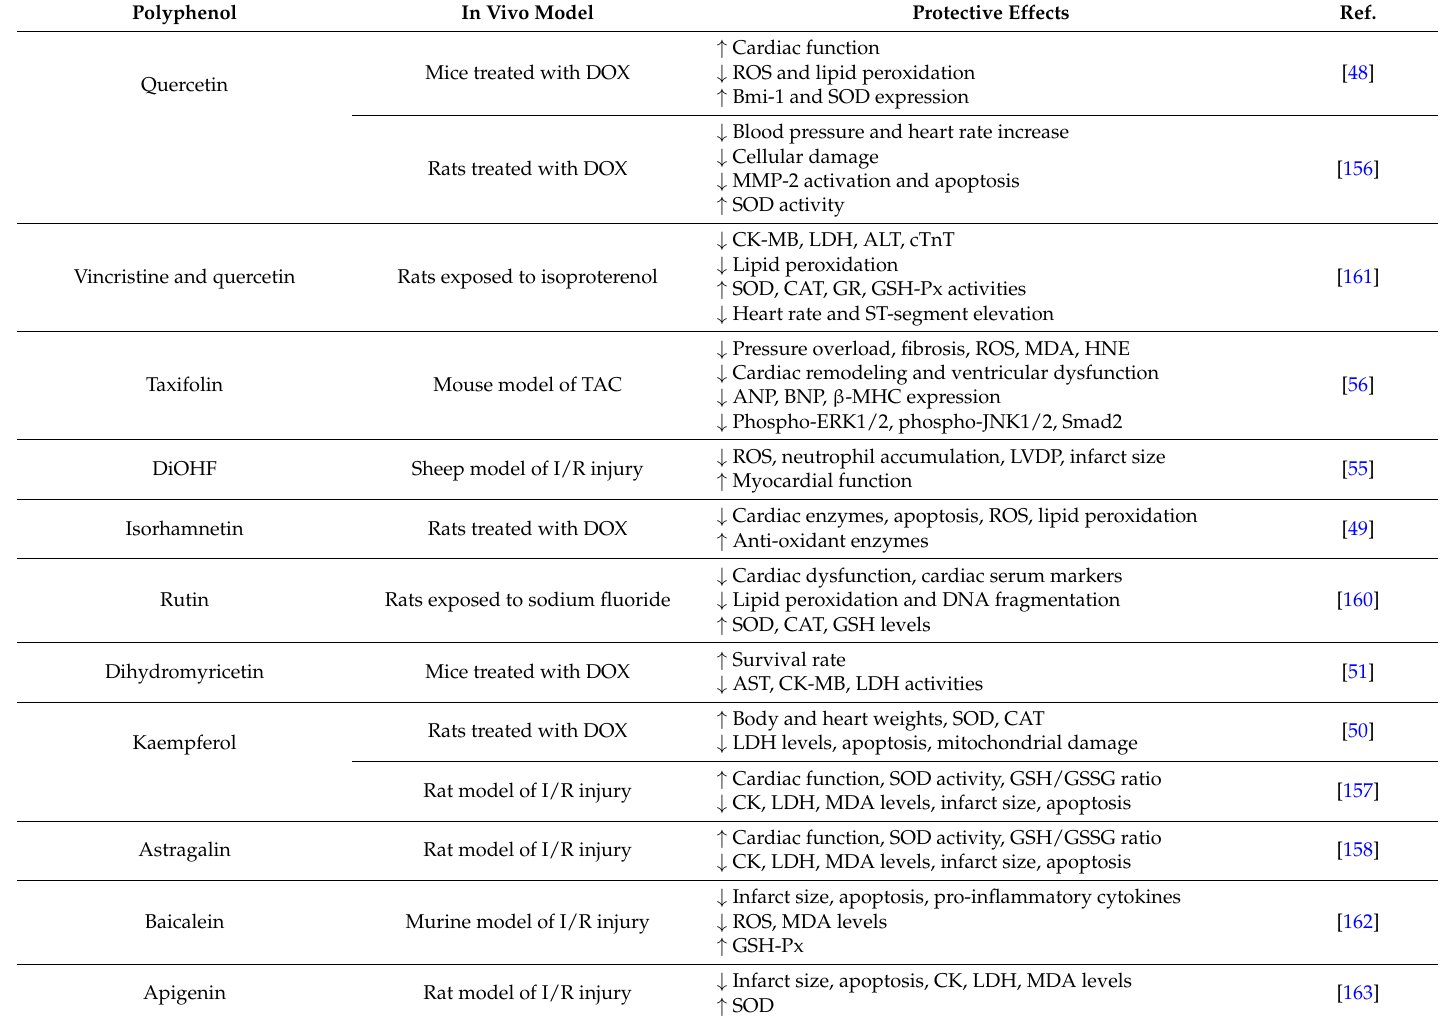
Table 2. In vivo protective effects of polyphenols against the oxidative stress-induced